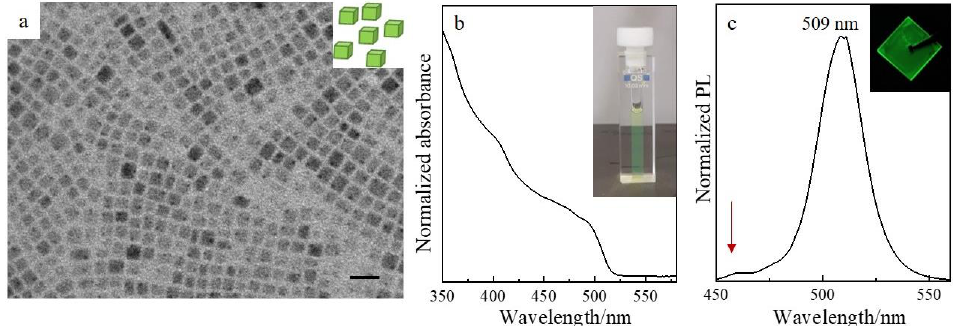
Figure 1. Transmission electron micrograph ( a , scale bar 20 nm), UV-Vis absorbance ( b ) and photoluminescence ( c ) spectra of organic-capped CsPbBr 3 NCs in toluene solution ( b ) and spin coated on quartz slide ( c ). Pictures of the colloidal CsPbBr 3 NCs solution under solar light illumination and of CsPbBr 3 NC thin film on quartz under 365 nm UV- lamp illumination are reported as inset in panel b and c, respectively.